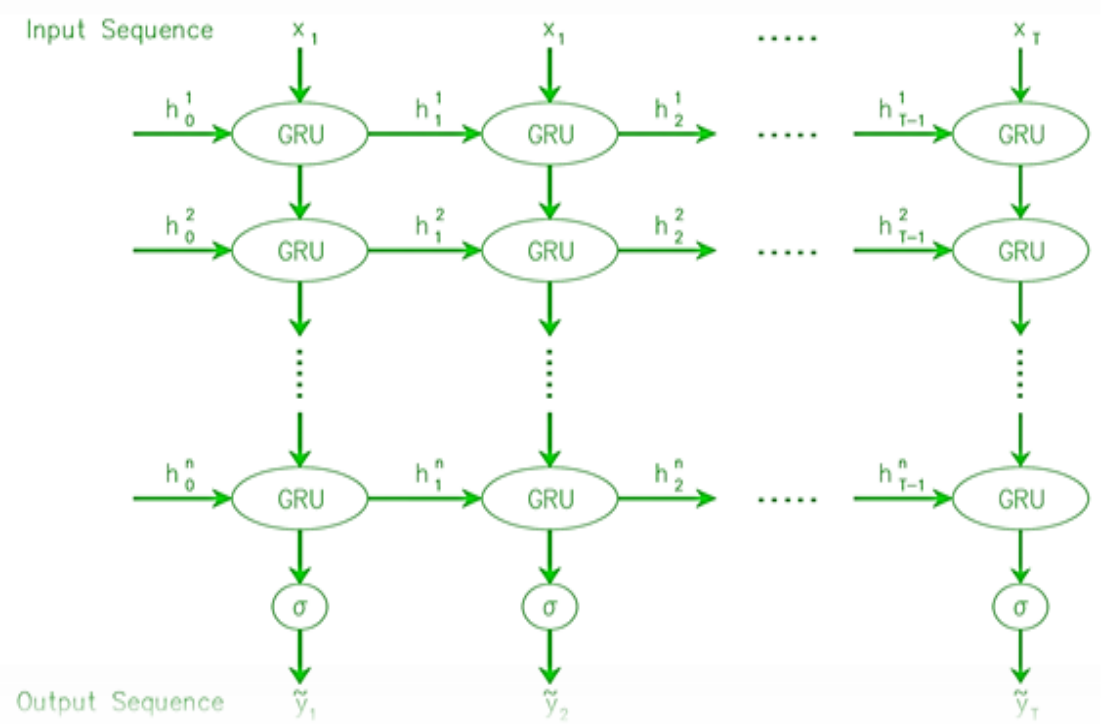
Figure 13. Basic architecture of stacked GRU model.